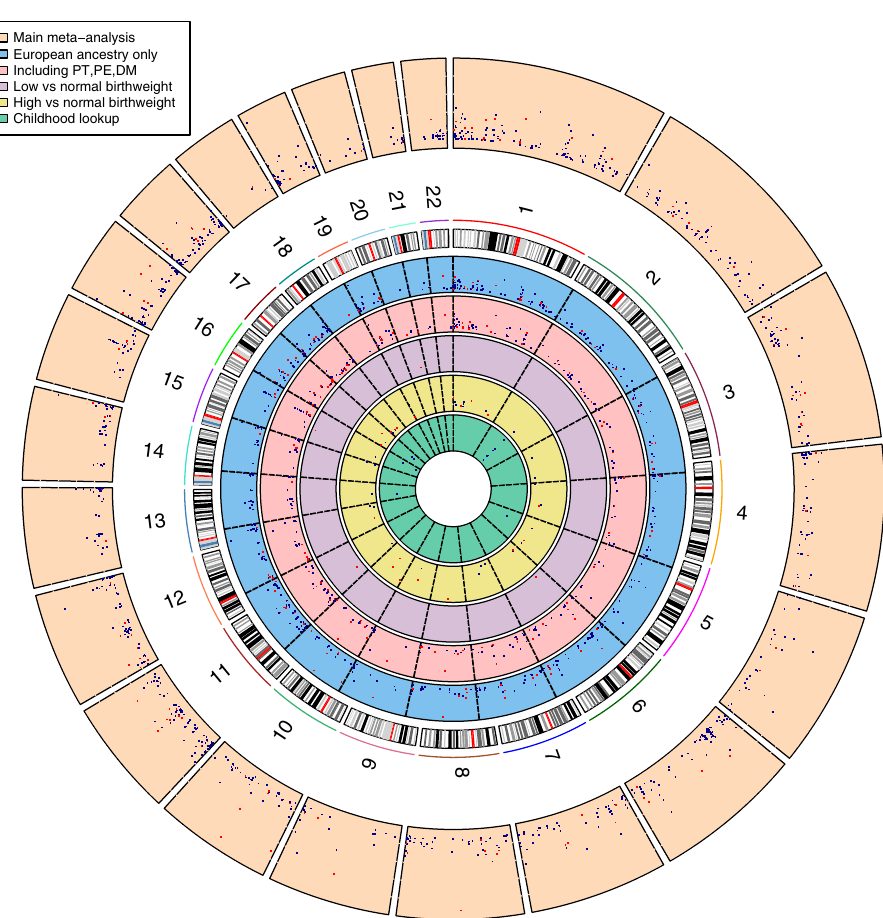
Fig. 4 Circos plot showing the (Bonferroni-corrected p < 1.06 × 10 − 7 ) results for associations of DNA methylation with birthweight. Results are presented as CpG-speci fi c associations ( − log 10 ( P ), each dot represents a CpG) by genomic position, per chromosome. From outer to inner track: [1, orange] Main analysis results for associations between DNA methylation and birthweight as a continuous measure ( n = 8825), [2, blue] Results from participants from European ethnicity only, DNA methylation and birthweight as a continuous measure ( n = 6023), [3, red] Results from analysis without exclusion for preterm births, pre-eclampsia and maternal diabetes, DNA methylation and birthweight as a continuous measure n = 5414), [4, purple] Results from logistic regression analysis without exclusion for preterm births, pre-eclampsia and maternal diabetes, for low ( n = 178) vs normal ( n = 4197) birthweight, [5, yellow] Results from logistic regression analysis for associations between DNA methylation and high ( n = 1590) vs normal ( n = 6114) birthweight, [6, green] Results from look-up analysis in methylation samples taken during childhood and its association with birthweight as a continuous measure ( n = 2756). Track 1: highlighted in red are 115 CpGs with I 2 > 50%. Tracks 2 – 6: highlighted in red are CpGs that were not found in the 914 main meta-analysis hits (though note differences in sample size and hence statistical power for different analyses presented in the different